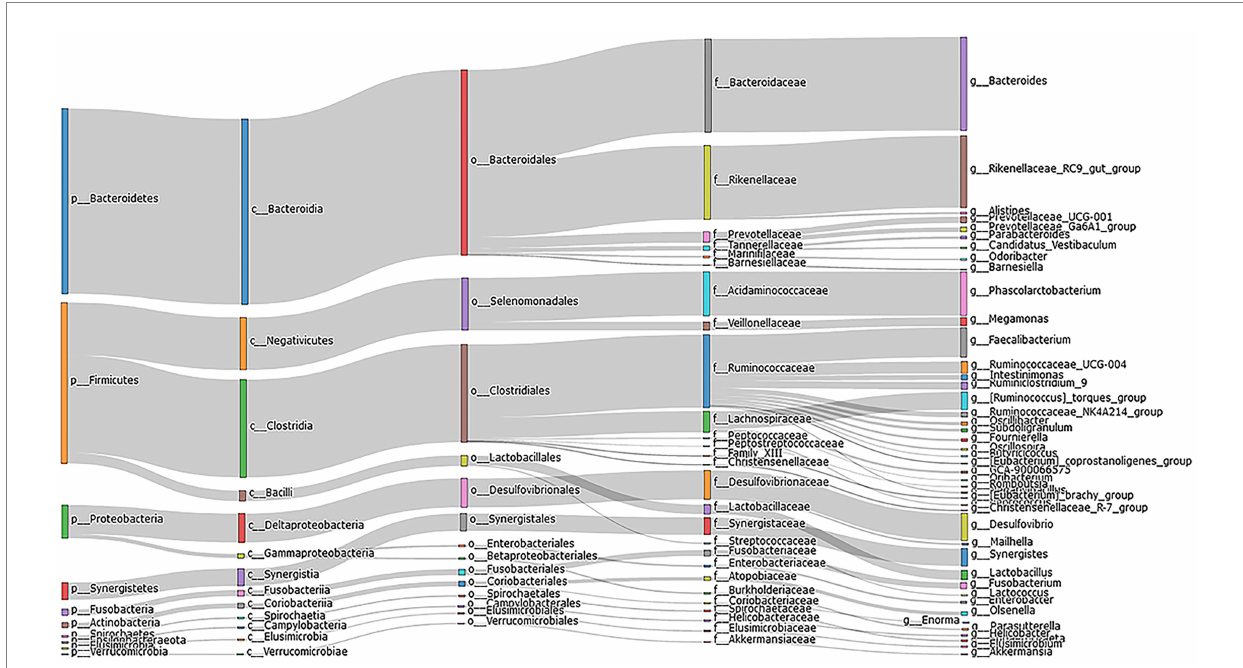
FIGURE 1 Sankey diagram depicting the bacterial composition of cecal content samples from Qiandongnan Xiaoxiang Chickens at 160 ± 3 days of age ( n = 24). The colored columns from left to right represent the proportions of bacterial taxa from phylum to genus level.